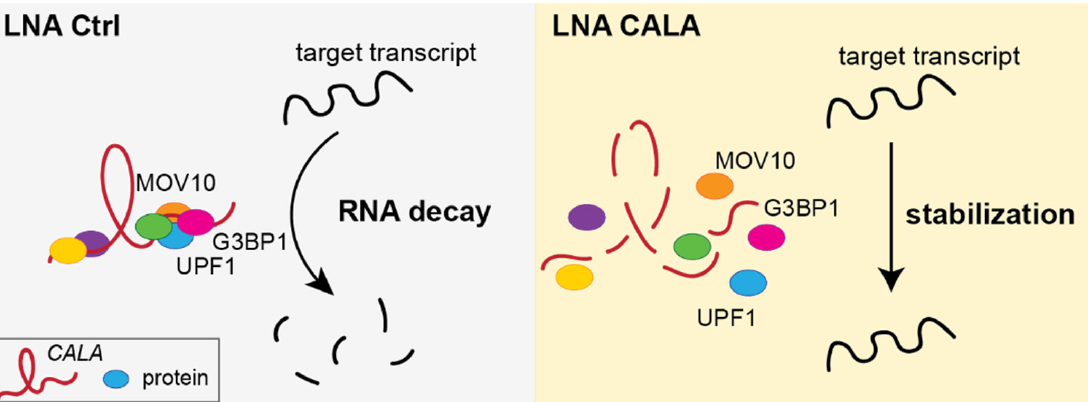
Figure 4. CALA promotes mRNA decay via cytoplasmic G3BP1-positive complexes. Model of CALA stabilizing cytoplasmic G3BP1-positive complexes, eventually enabling mRNA decay. Silencing of CALA disrupts the cytoplasmic interaction of G3BP1 with NMD regulatory factors including UPF1 and MOV10, ultimately compromising the decay of mRNAs.